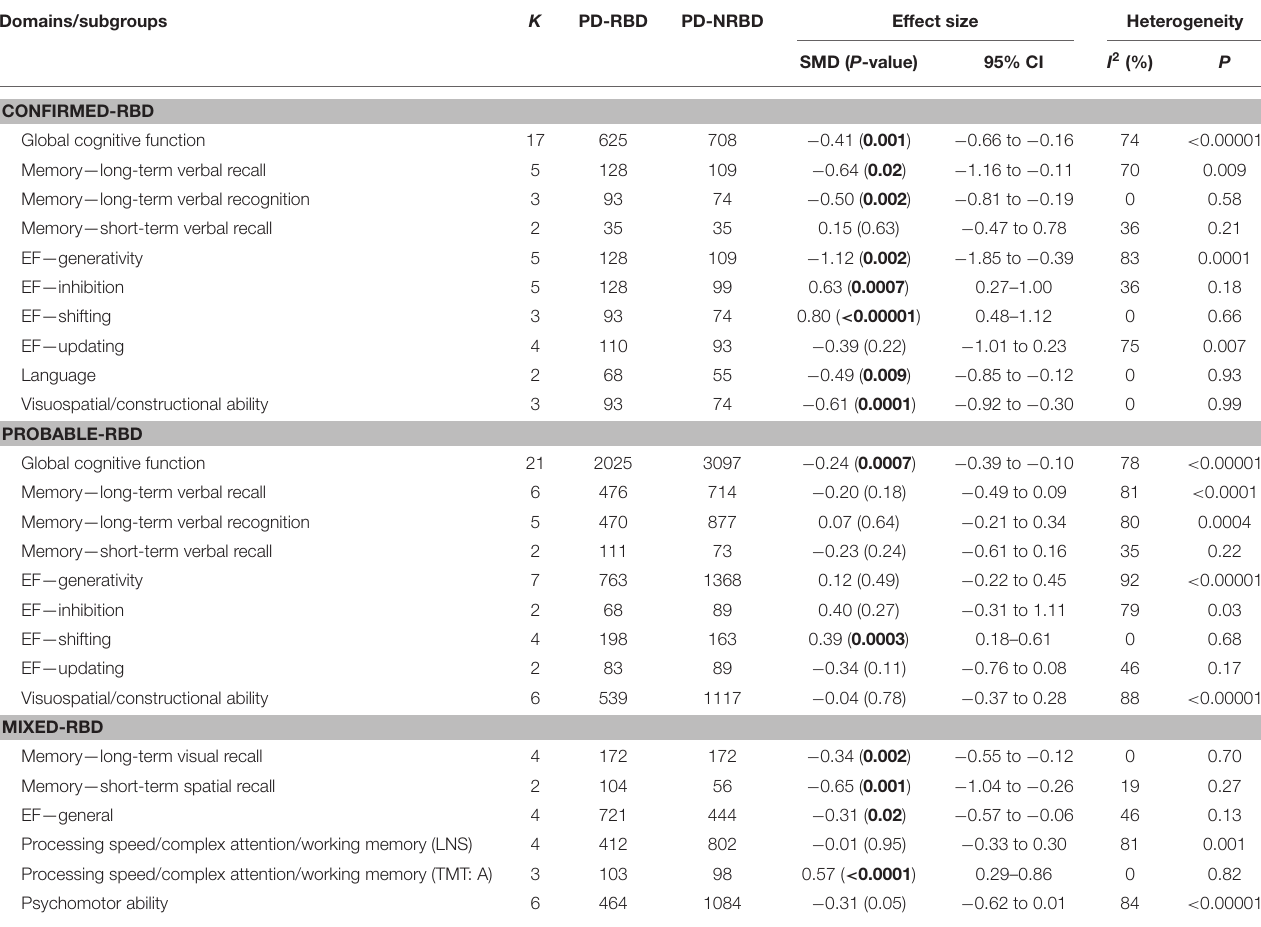
TABLE 3 | Summary of the meta-analytic results of the following cognitive dimensions. Domains/subgroups K Effect